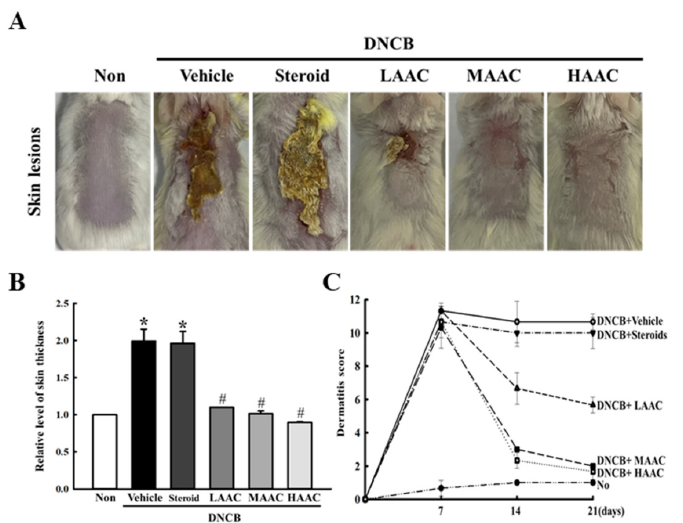
Figure 7. Skin phenotypes of DNCB-treated BALB/c mice spread with AAC. ( A ) Actual image of skin lesions. After the final treatment, images were taken with a digital camera. ( B ) Level of skin thickness. Before a necropsy, the thickness of the skin in mice of subset groups was measured using a thickness gauge, as described in the Materials and Methods. ( C ) Dermatitis score. During the experimental period, the dermatitis scores were determined based on the SCORing Atopic Dermatitis (SCORAD) index. The skin lesion and thickness experiments were performed on four to six mice per group, and the parameters for these experiments were analyzed in duplicate. All values in the results are represented as the means ± standard deviation (SD). * indicates statically significance compared to the non-treated group, while # indicates statically significance compared to the DNCB+Vehicle-treated group. Abbreviations: AA, abietic acid; DNCB, 2,4-dinitrochlorobenzene; LAAC, low concentration of AA cream; MAAC, medium concentration of AA cream; HAAC, high concentration of AA